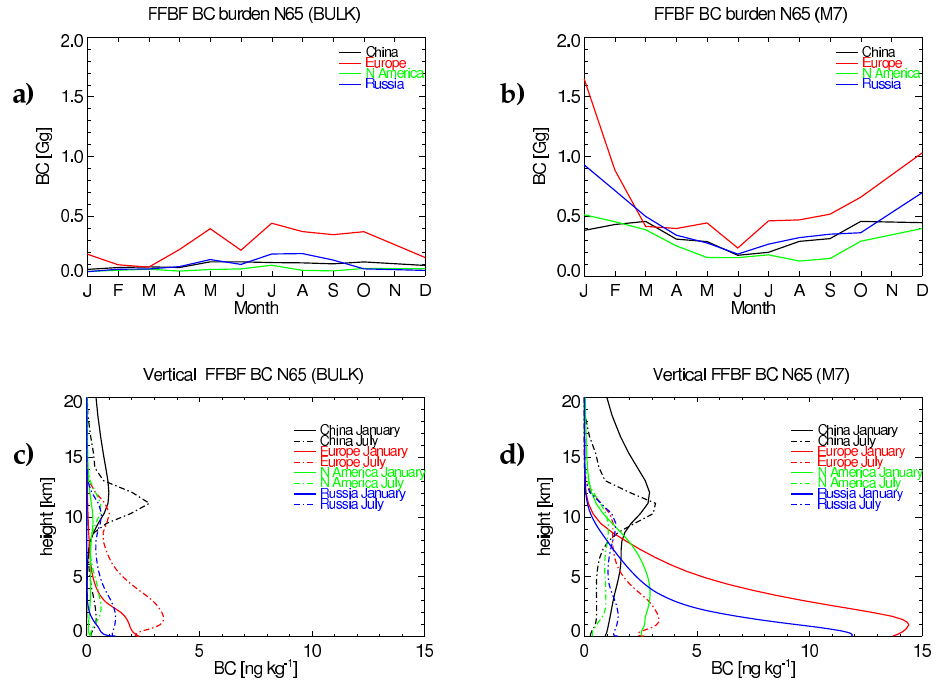
Fig. 5. Regional contribution from Europe, Russia, China and North America to monthly mean fossil and biofuel (FFBF) BC burden [Gg] in the atmosphere north 65 ◦ N with (a) BULK and (b) M7, and to vertical distribution [ngkg − 1 ] of fossil and biofuel BC in January (solid) and July (dashed) with (c) BULK and (d)